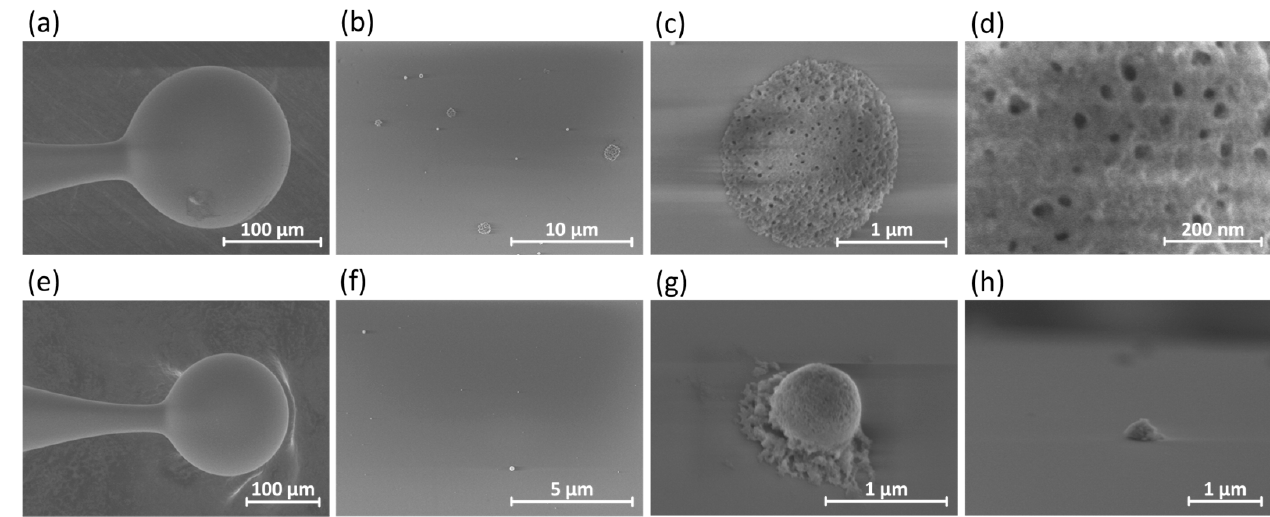
Figure 1. Illustration of 170 µm SiO 2 microsphere resonator scans captured by SEM at 3 kV after artificial degradation by 100% humidity exposure: ( a ) 4.1 mm @×400 times, ( b ) 4.0 mm @×5.00 k times, ( c ) 4.0 mm @×45.0 k times, ( d ) 2.9 mm @×180 k times, and captured illustrations for newly fabricated 170 µm SiO 2 microsphere: ( e ) 4.0 mm @×300 times, ( f ) 4.0 mm @×10.0 k times, ( g ) where evaporated silica from the arc fusion splicer discharge at 4.0 mm @×50.0 k times, and ( h ) nanoscale particles at 4.0 mm @×30.0 k times were observed.